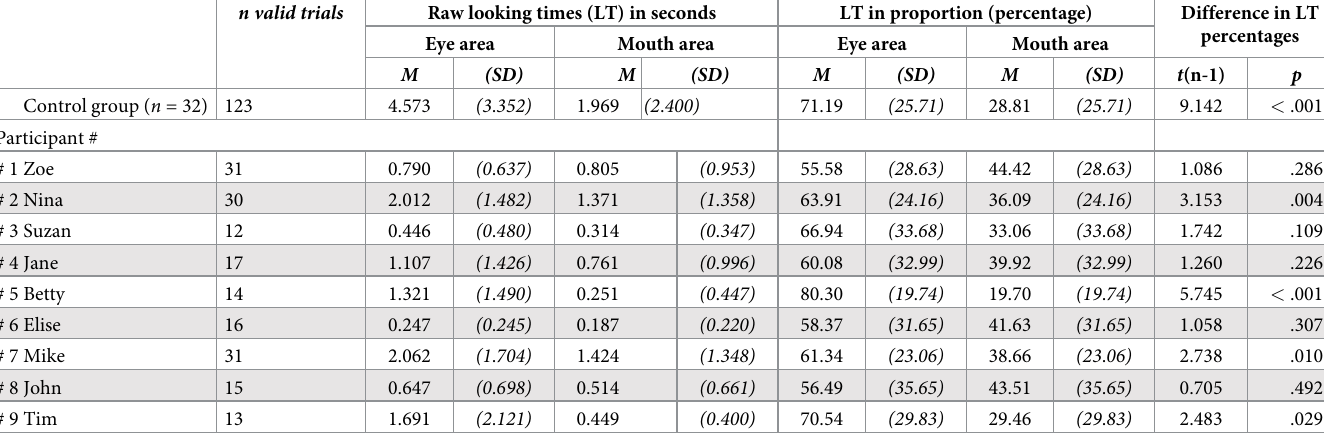
Table 7. Mean (and SD ) looking times (raw and percentage) at each of the two facial AOIs (i.e., eye vs. mouth areas) of the control group and the nine PIMD partic- ipants recorded during the repeated presentation (four 20-second trials) of pairs of male and female happy and angry faces. n valid trials